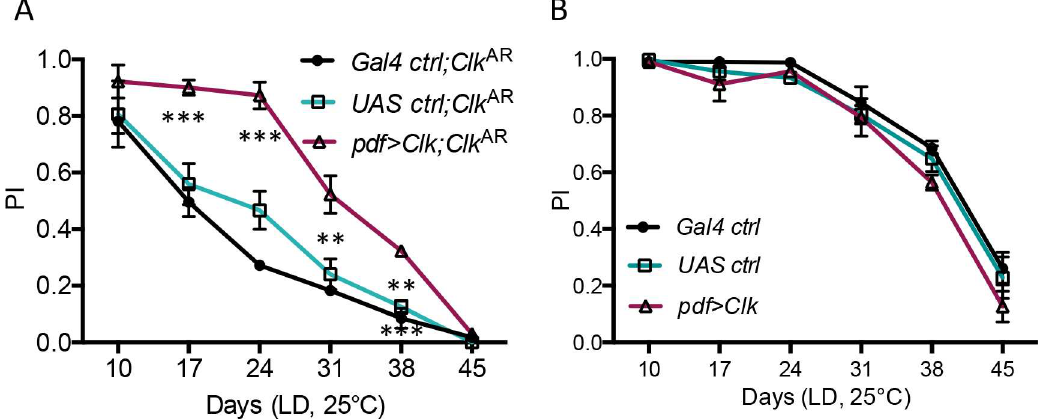
Fig 3. Rescue of Clk AR ARLI phenotype by Clk expression in the PDF-expressing pacemakerneurons. (A) Reintroducing Clk expressionin the PDF neuronsof Clk AR flies (pdf > Clk;Clk AR ) significantly rescued the premature locomotor declineof the Clk AR mutation. (B) Clk overexpression in PDF neuronshad no effect on SING declinein a wild- type background. Graphs displaythe means ± SEM from 2 independent